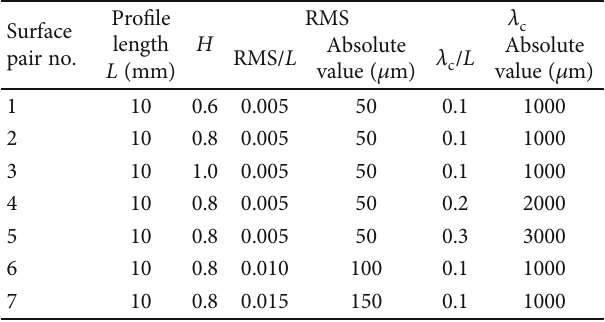
Table 2: Summary of the seven synthetic